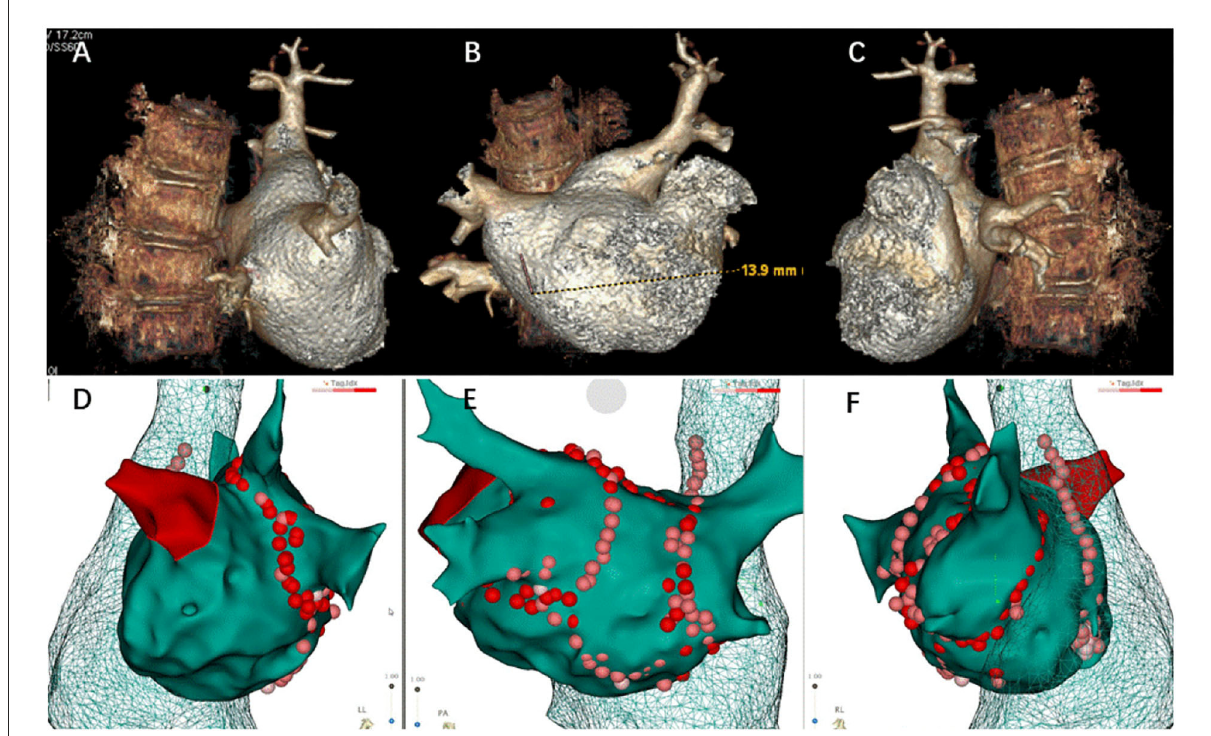
FIGURE2 Three-dimensional reconstruction of pulmonary vein and ablation circle (red-colored) using the CARTO3 ® system. (A) Three-dimensional reconstruction of the pulmonary vein in left lateral view. (B) Three-dimensional reconstruction of the pulmonary vein in posteroanterior view. (C) Three-dimensional reconstruction of the pulmonary vein in right lateral view. (D) Ablation circle in left lateral view. (E) Ablation circle in posteroanterior view. (F) Ablation circle in right lateral